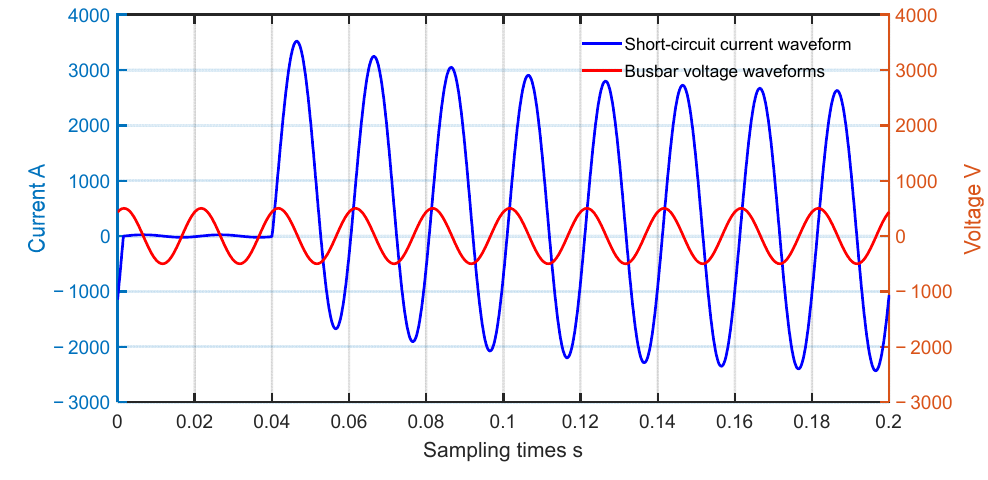
Figure 2. Voltage and current waveform.